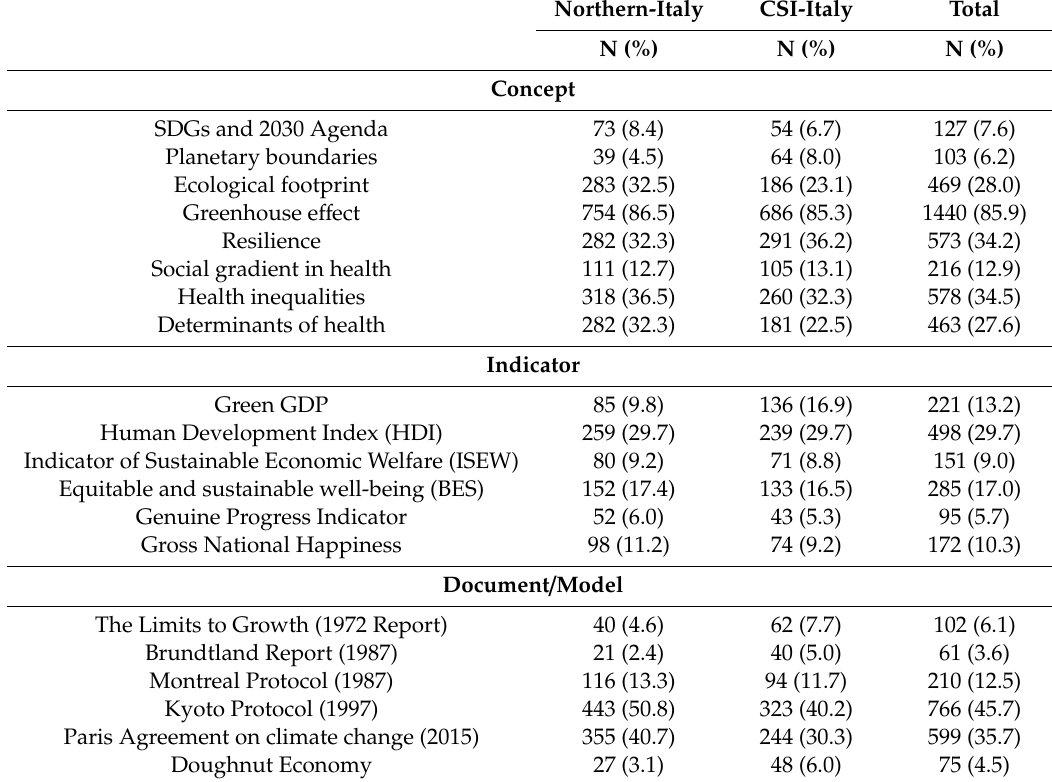
Table 1. Number and percentage of respondents declaring good knowledge for each surveyed item; results reported for Northern and